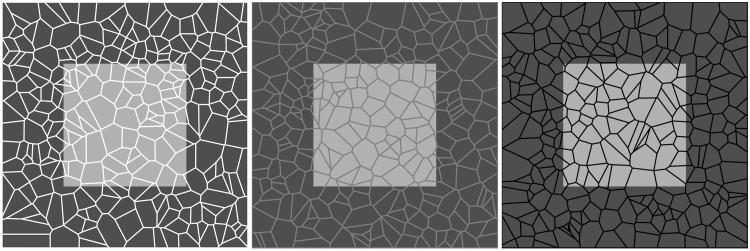
The effect seen in Figure 1 top row appears also for the simplest artificial configurations as here a light square on a dark ground. The square at left appears as an integral object behind a white lattice, whereas the square at right looks fragmented, being tessellated by the grid. In the case at left the square and the lattice appear in different depth planes. Curiously, the square looks lighter because of the assimilation (von Bezold, 1874; Musatti, 1953) induced by the white grid. Apparently assimilation works across depth planes, which is a notable finding by itself (Agostini & Galmonte, 2000). In the figure at center, unlike those at left or right, the mesh appears dark on some parts and light on the other. The square appears to lie behind a trellis, the latter appearing in front of both the square and the dark background. This is the condition used in most of our demos and experiments (Koenderink et al., 2012a, 2012b).